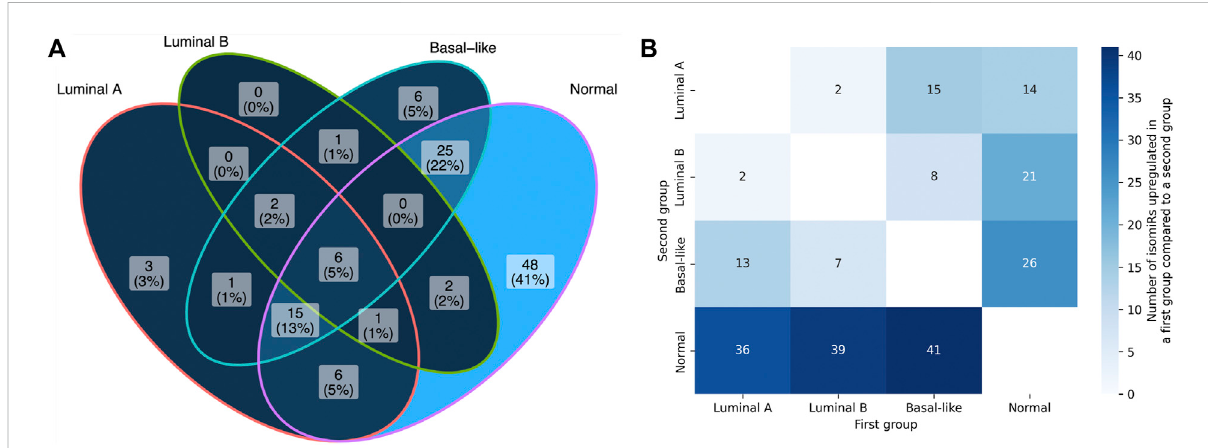
FIGURE 4 Differential 5 ′ -isomiRs activity and expression in four analyzed sample groups. (A) the mutual arrangement of the sets of signi fi cantly active 5 ′ - isomiRs (adjusted ITA FDR < 0.05) in four sample groups. (B) the results of pairwise differential 5 ′ -isomiR expression analysis. Each cell contains